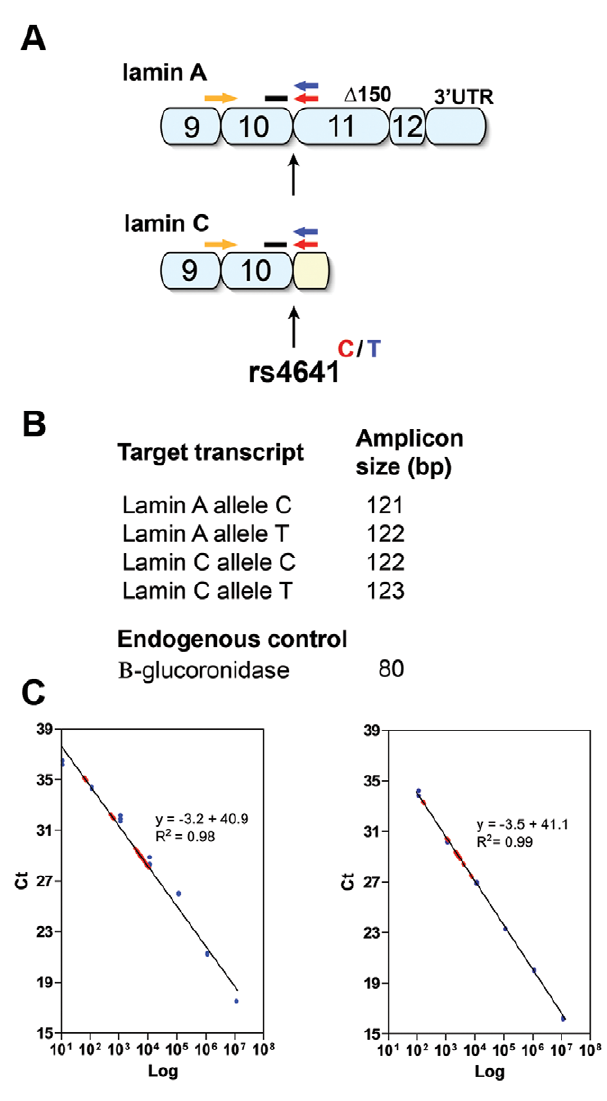
Figure 1. TaqMan assays for allele-specific absolute quantifica- tion of the LMNA transcripts lamin A and lamin C. (A) Schematic illustration of the location, in the 3 9 end of the lamin A and lamin C cDNA, of the primers and probes used in the different assays. The rs4641 SNP is located in the last nucleotide of exon 10, which is present in lamin A and lamin C transcripts. The forward primer, 5 9 -CAACTCCACTGGGGAA- GAAGTG-3 9 (orange arrows), and the TaqMan MGB probe, 5 9 -ATGCG- CAAGCTGGTG-3 9 (black bars), were the same in all 4 assays. Reverse primers (blue and red arrows) make the assay specific for each allele and transcript by allele-specific 3 9 -end termination. The reverse primer in the lamin A allele C assay was 5 9 -GCTGCAGTGGGAGCCG-3 9 in the lamin A allele T assay, 5 9 -TGCTGCAGTGGGAGCCA-3 9 in the lamin C allele C assay, transcripts also results in co-amplification of the lamin A D 150 and lamin C2, respectively. (B) Target transcripts and sizes of the PCR products of the 4 designed TaqMan assays and the endogenous control. (C) Standard curves of plasmids containing the assay-specific amplicon, estimated absolute copy numbers of transcript lamin C allele C (left) and transcript lamin C allele T (right). A minimum of 5 standards (blue) ranging